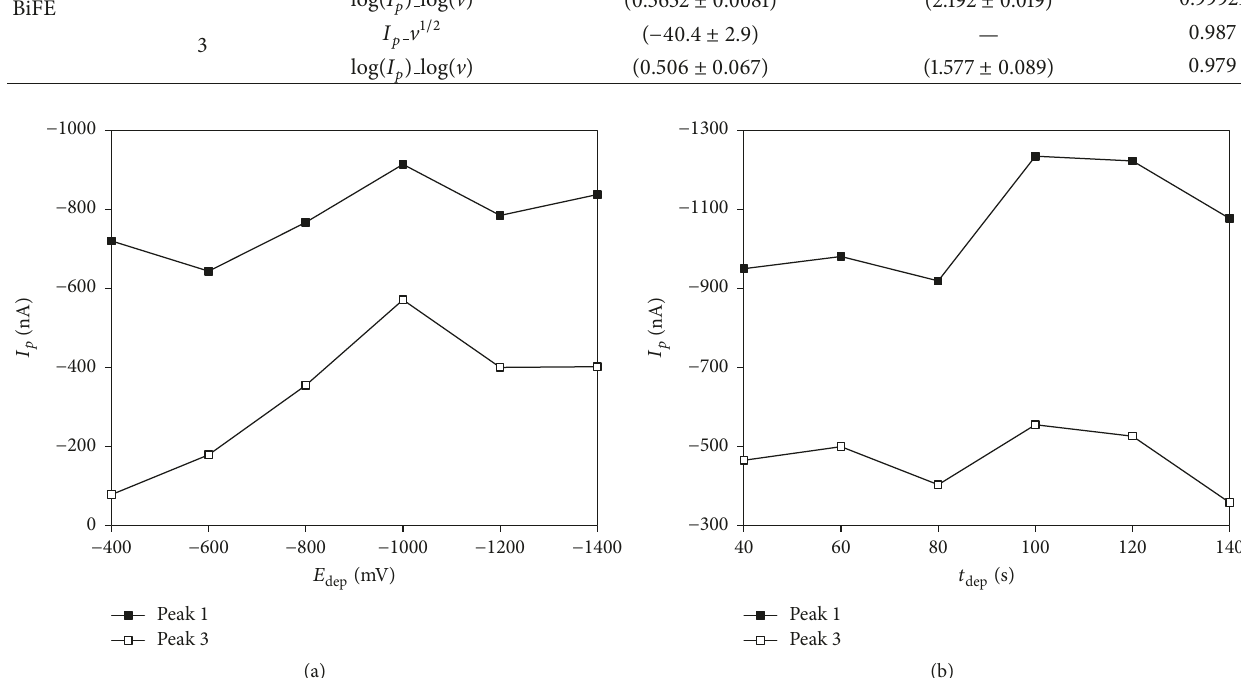
(a) and 𝑡 (b) of Bi film deposition. Method: DPV; electrolyte: BRB (pH 5.0); 𝐸 in = +200 mV; 𝐸 fin = − 1100mV; dep dep = 2.0 × 10 −5 molL −1 ; plating solution: AB (pH 4); 𝐸 DAN